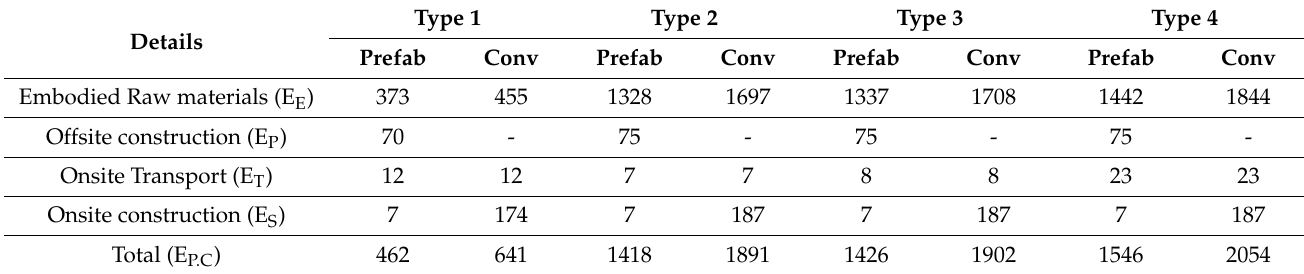
Table 5. Energy consumption (GJ) production to and construction phases.